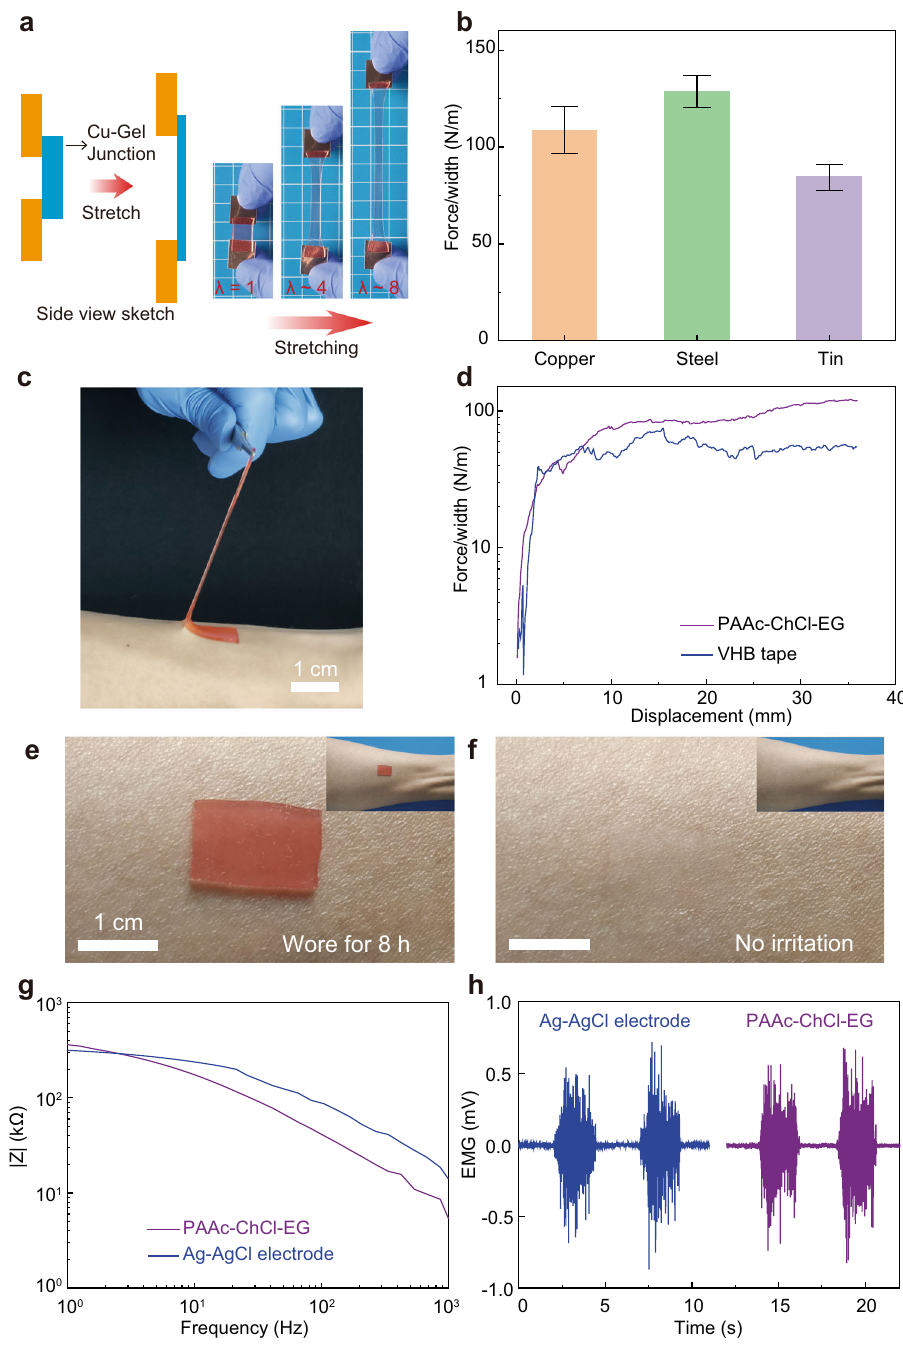
Fig. 3 Adhesive performance of the PAAc – ChCl – EG gel and its application for on-skin electrodes. a Sketch and photograph using the PAAc – ChCl – EG gel to adhere two copper strips. b The measured peeling forces per width of the PAAc – ChCl – EG gel on copper, steel, and tin. c Photograph of pulling a PAAc – ChCl – EG gel away from the skin of a forearm. d Comparison of the adhesion behavior of the PAAc – ChCl – EG gel with a VHB tape. e Photograph of the gel attached on the skin for 8 h. f Photograph of the skin after removing the PAAc – ChCl – EG gel. g Impedances of the PAAc – ChCl – EG gel and the Ag – AgCl electrode on the skin. h Recorded EMG signals using DES gel electrode and Ag – AgCl electrode. Values in panel b represent the mean and standard deviation ( n =